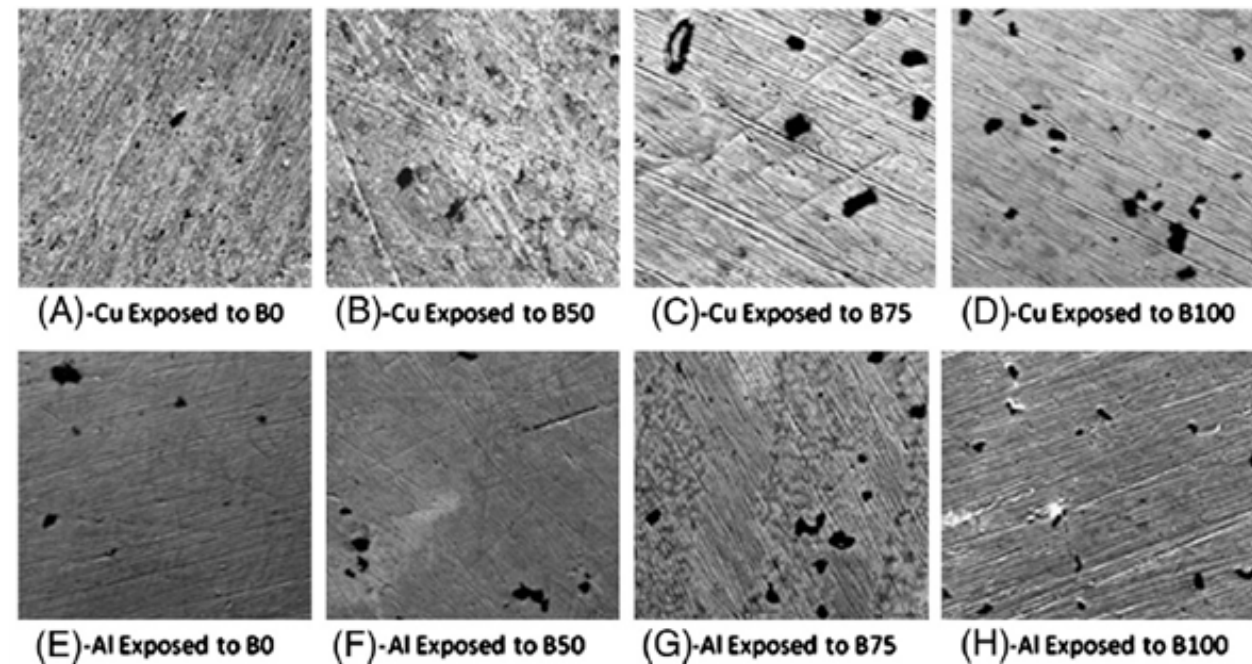
Figure 18. SEM photographs of surfaces exposed to fuel blends [72].